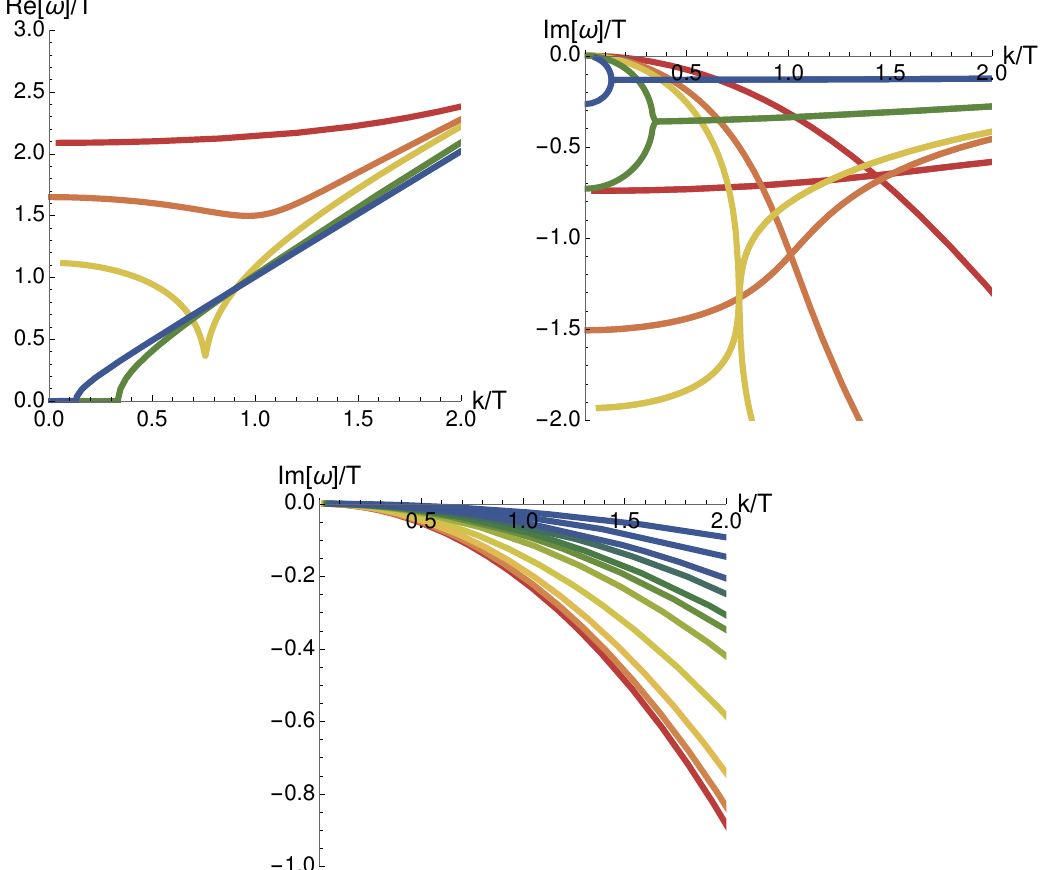
Figure 12 . Top panel: real and imaginary parts of the lowest collective modes for (cid:12)xed (cid:21) = 1 and (cid:22)=T = 4 increasing the dimensionless SSB strength (cid:11) 3 =T = (0 : 1 ; 3 : 75 ; 5 ; 10 ; 25) (red-blue). The gapped plasmon smoothly crossovers to the ungapped normal sound mode. For clarity, we manually removed the decoupled crystal di(cid:11)usion mode. Bottom panel: the decoupled crystal di(cid:11)usion mode for (cid:11) 3 =T = [0 : 1 (cid:0) 25]